Question: According to the figure, is the described quantity increasing or decreasing?
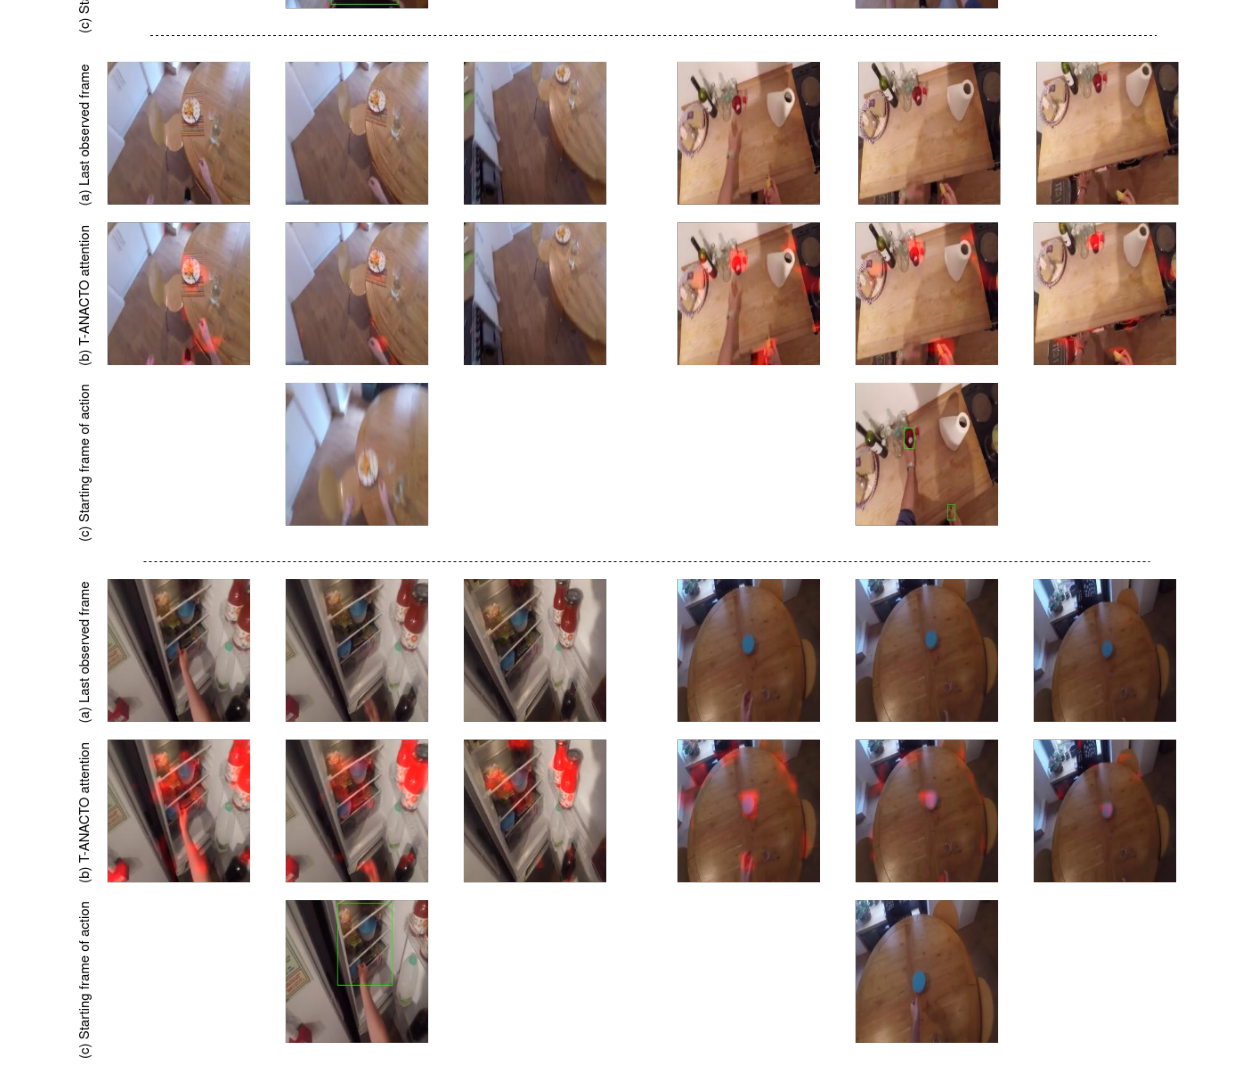
Answer: decreasing